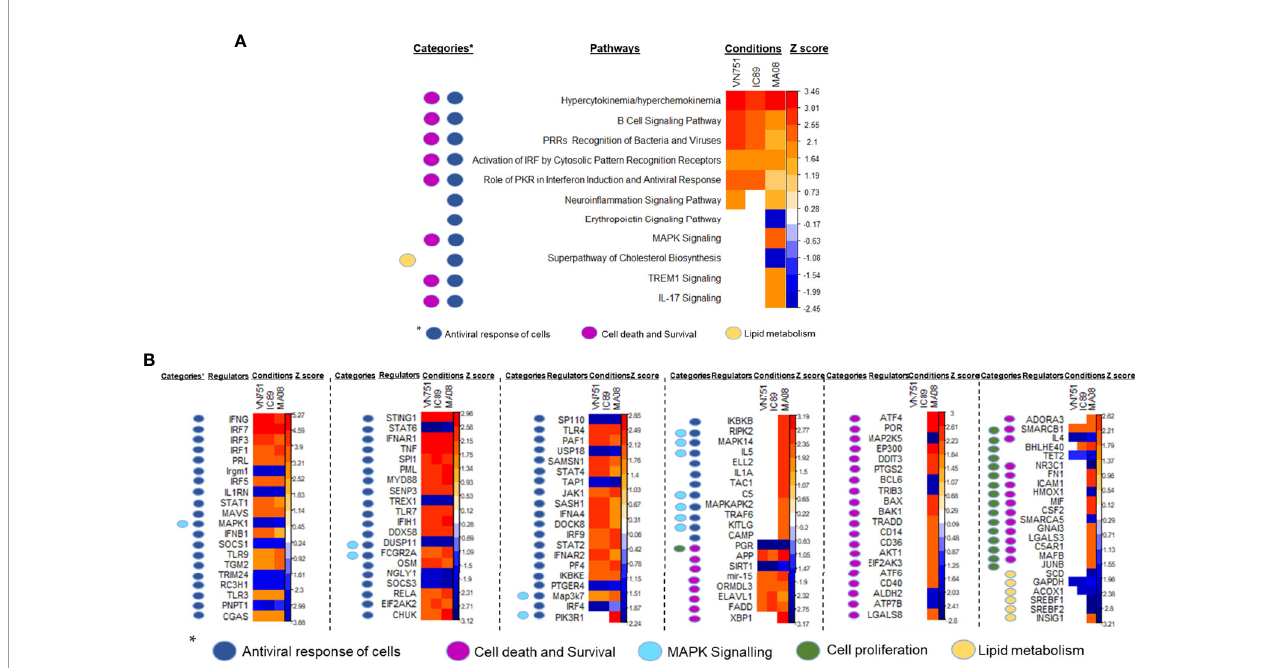
FIGURE 4 | Identi fi cation of pathways and upstream regulators modi fi ed by PPRV infections at 72 hpi. Qiagen ’ s IPA software provided a Zscore that informs on the activation status of pathways (A) and upstream regulators (B) . Positive zscores (upregulated) are represented by an orange gradient while negative zscores (downregulated) are represented by a blue gradient. Pathways and upstream regulators have been classi fi ed in categories related to antiviral cell responses (dark blue square), MAPK signalling (light blue square), lipid metabolism (yellow square), cell death, survival (violet square) and proliferation (green square).